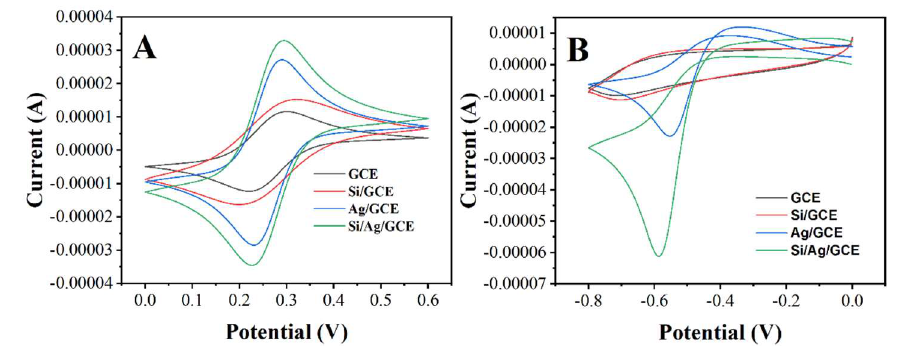
Figure 2. ( A ) CV profiles of GCE, Si/GCE, Ag/GCE and Ag/Si/GCE in 5 mM [Fe(CN) 6 ] 3 − /4 − . ( B ) CV profiles of GCE, Si/GCE, Ag/GCE and Ag/Si/GCE in 0.1 M PBS with 0.5 mM H 2 O 2 (pH = 7.0).